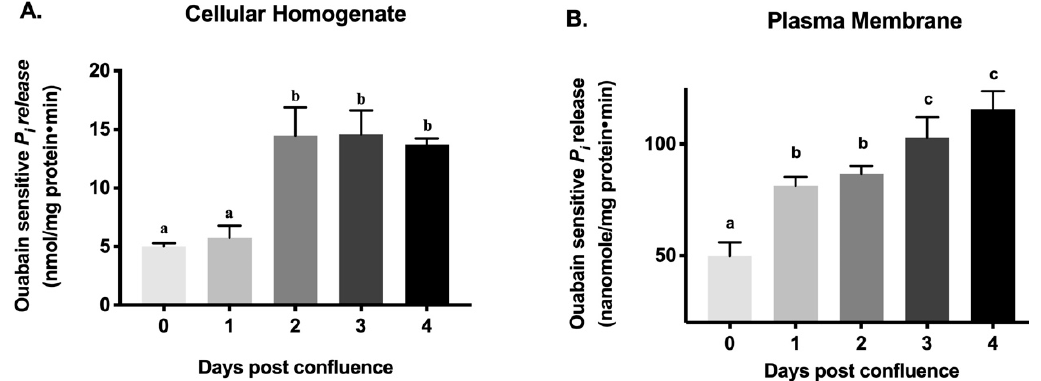
Figure 3. Na-K-ATPase activity as measured by P i release in IEC-18 cells. Na-K-ATPase activity was measured in the presence or absence of ouabain (1 mM). The absolute Na-K-ATPase activity presented was calculated by subtracting P i release in the presence of ouabain from that in the absence of ouabain. ( A ) Cellular homogenates. ( B ) Plasma membrane preparations. Values are represented as means ± SEM, n = 5. Values not sharing common superscripted letters are significantly different at p < 0.01.